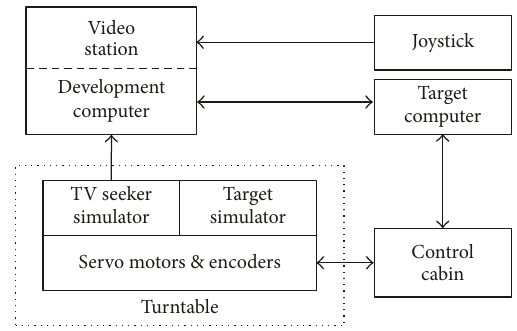
Figure 2: System